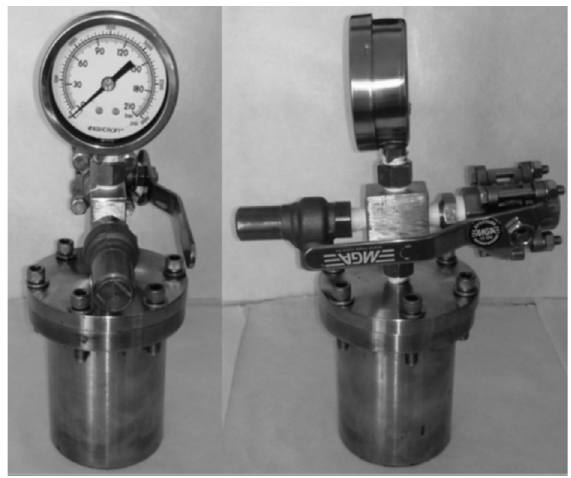
Figure 1 - Front and side view of the assembled CHT reactor (container +